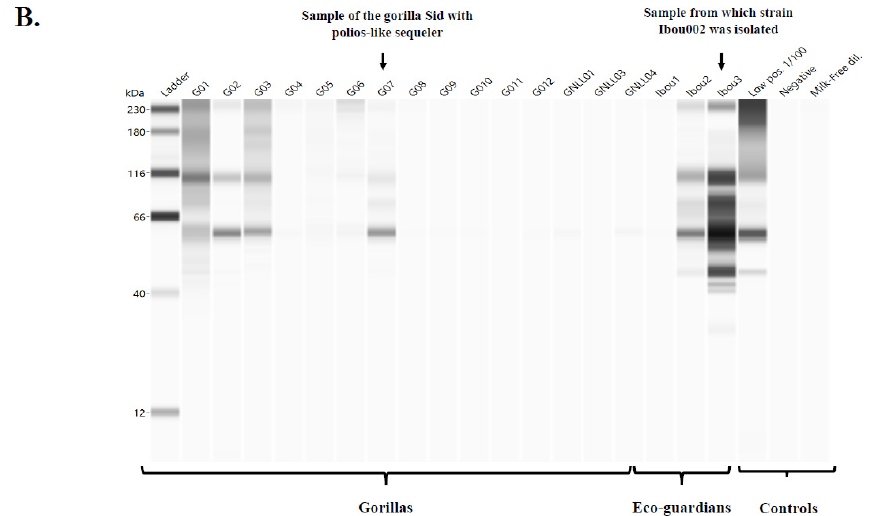
Figure 7. Western blot JessTM using two different antigens, poliovirus vaccine ( A ) and Ibou002 virus strain ( B ). Anti-human IgG/IgA antibody detection was performed for 16 gorilla stools, three human stools, and one control positive serum (non-diluted and diluted 1:100).